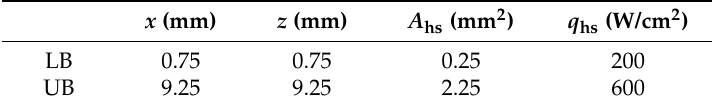
Table 3. Hotspots for the HS1 scheme.